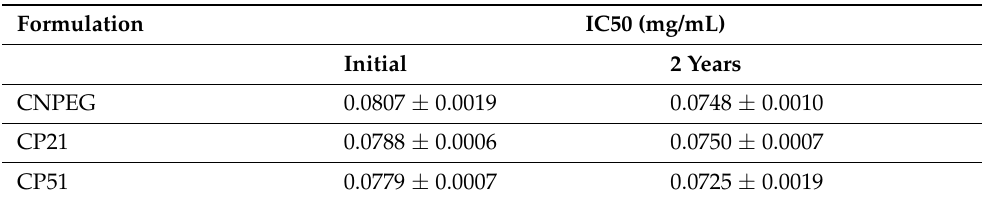
Table 7. IC50 values from DPPH assay on selected nanoemulsion formulations. The values are presented as mean ± sd ( n =